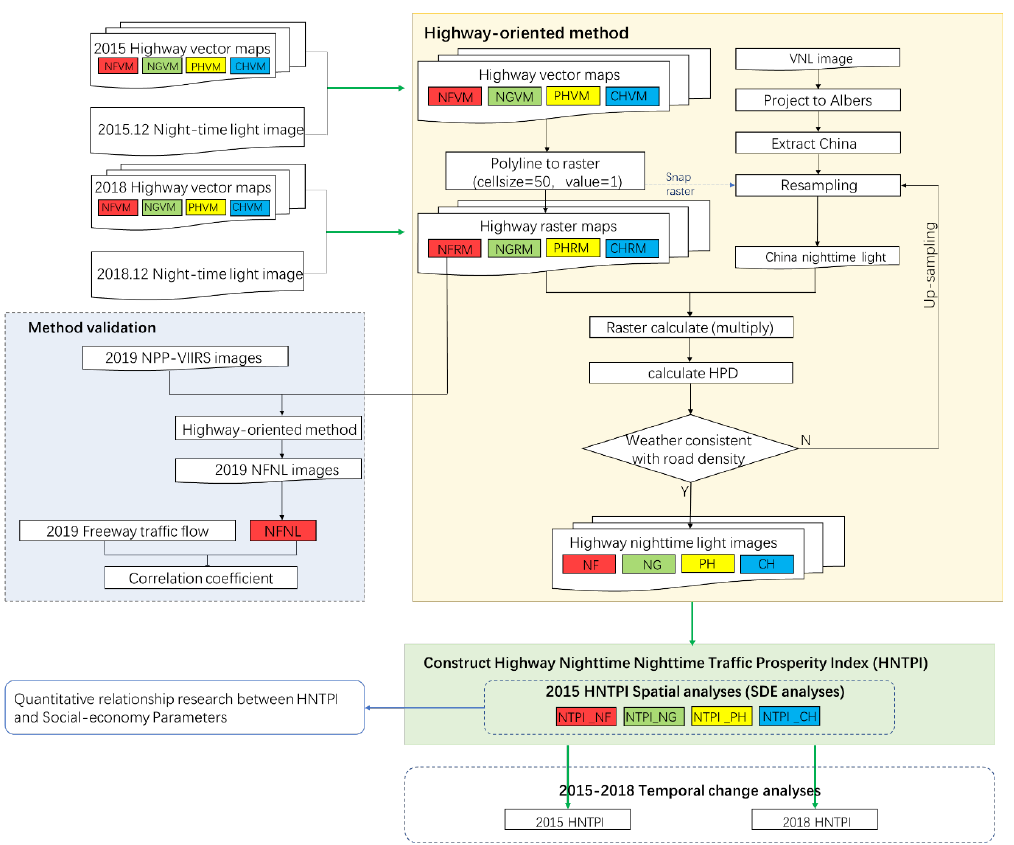
Figure 4. The frame structure of the paper.